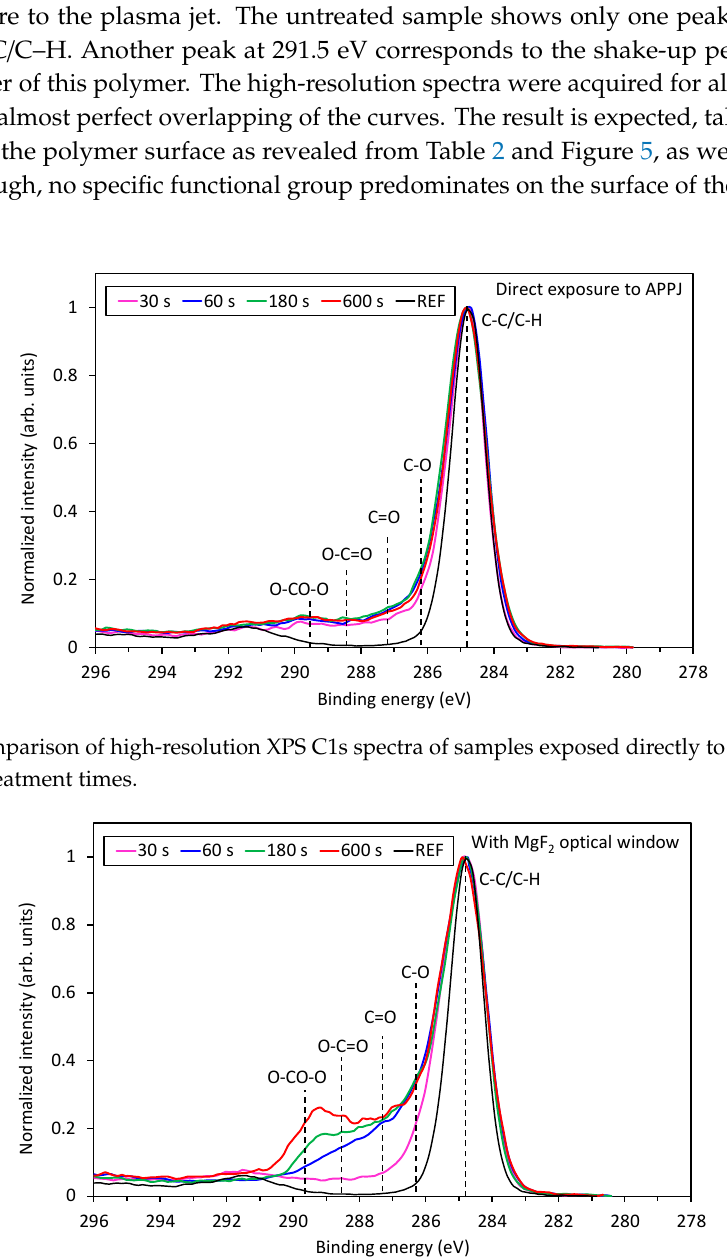
Figure 7. Comparison of high-resolution XPS C1s spectra of samples covered with MgF 2 optical window and thus treated with VUV radiation for various treatment times.